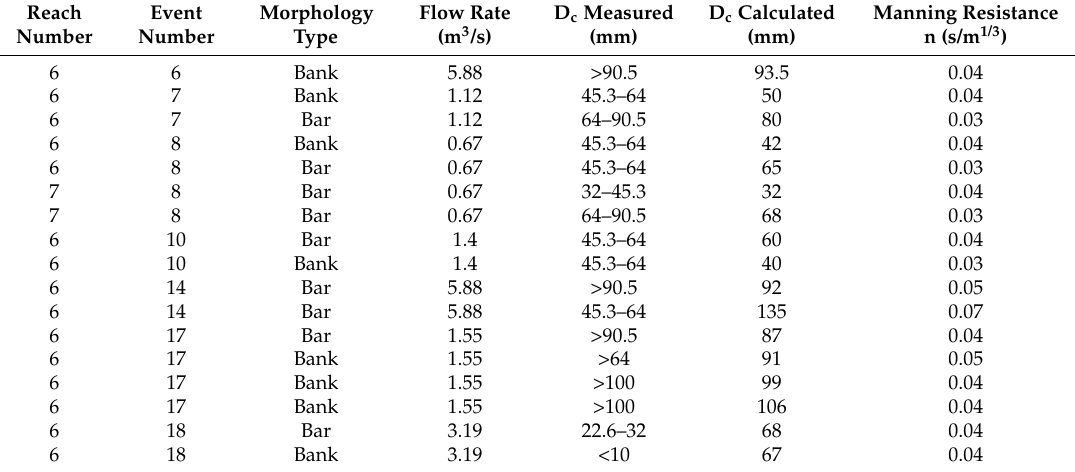
Table 4. Critical diameter (D c ) comparison table. Flowrate was measured in the surveyed